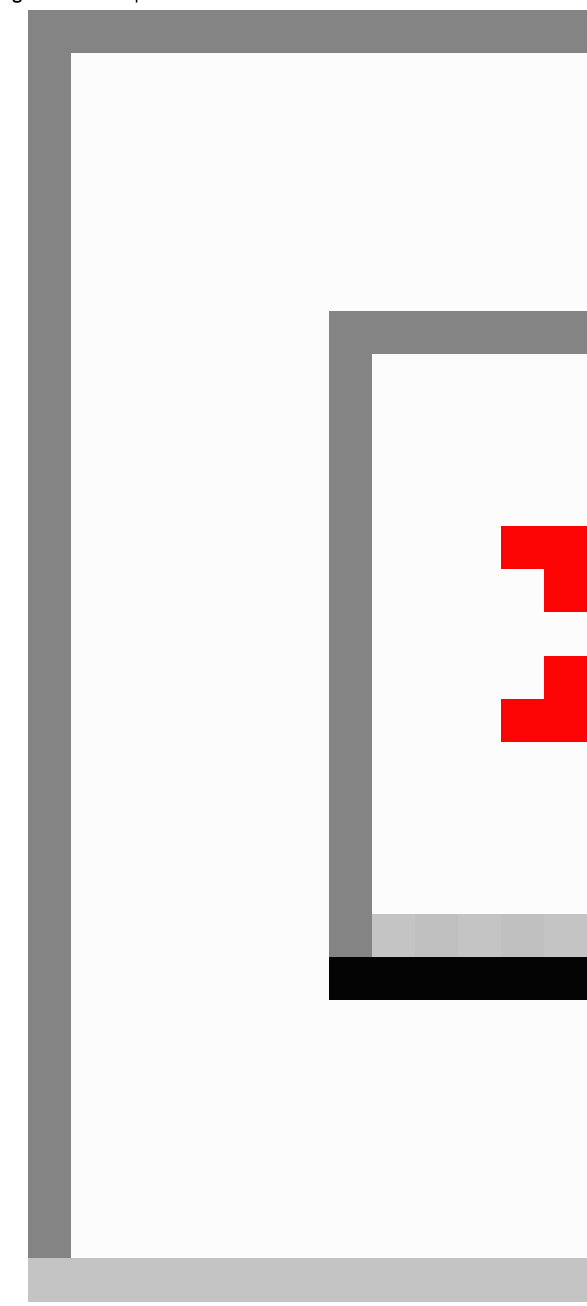
Figure 8. Example of menu